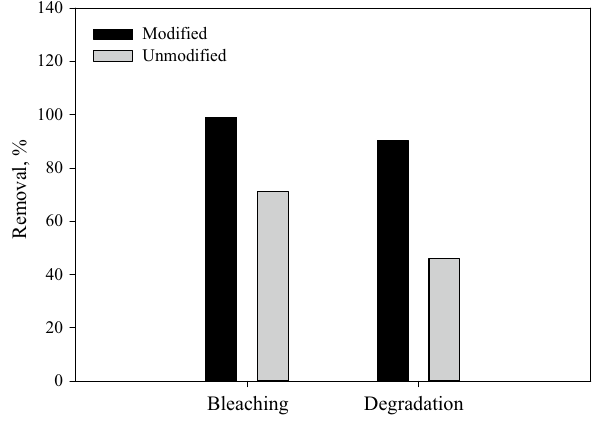
Fig. 13 Effect of surface modification of activated carbon on the rate bleaching and dye degradation of MO. pH 6, 20 mg L −1 photocata- lyst, methyl orange 10 mg L −1 , time 160 min